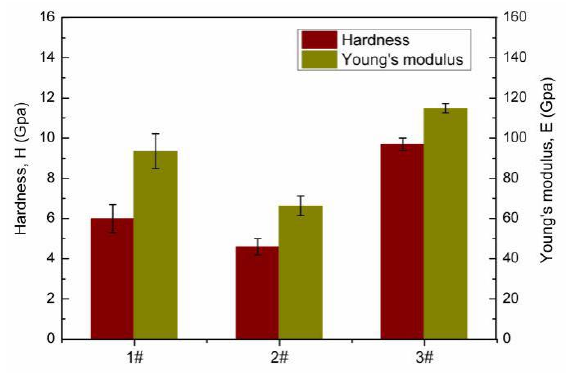
Figure 10. Hardness and Young’s modulus of LC coatings.